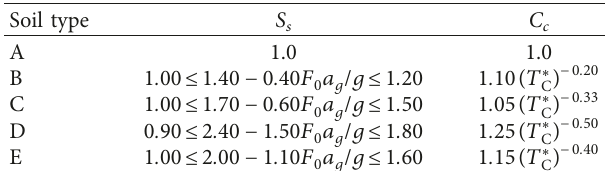
Table 8: Stratigraphic amplification coefficient in the Italian code